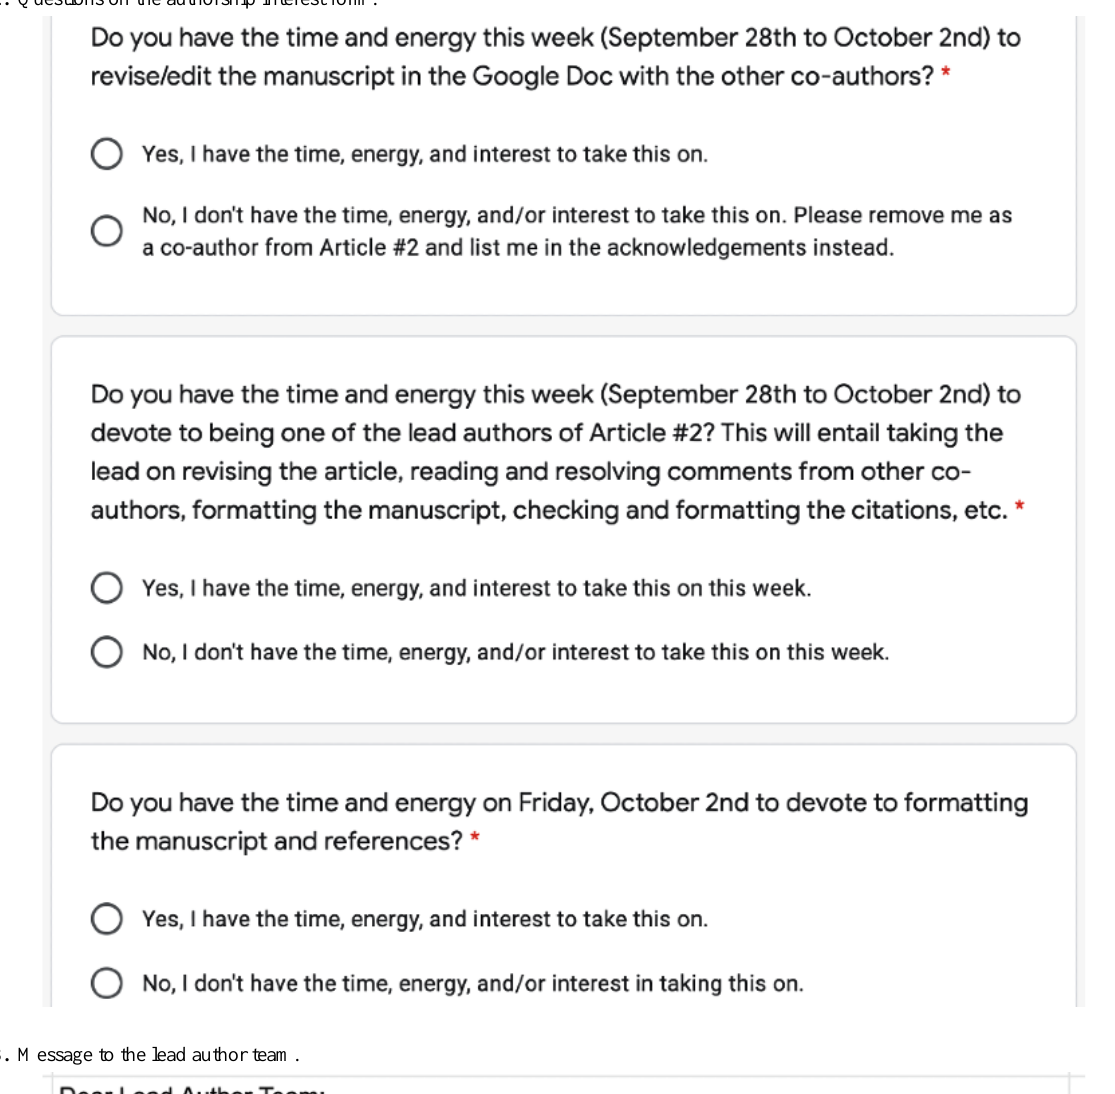
Figure 3. Message to the lead author